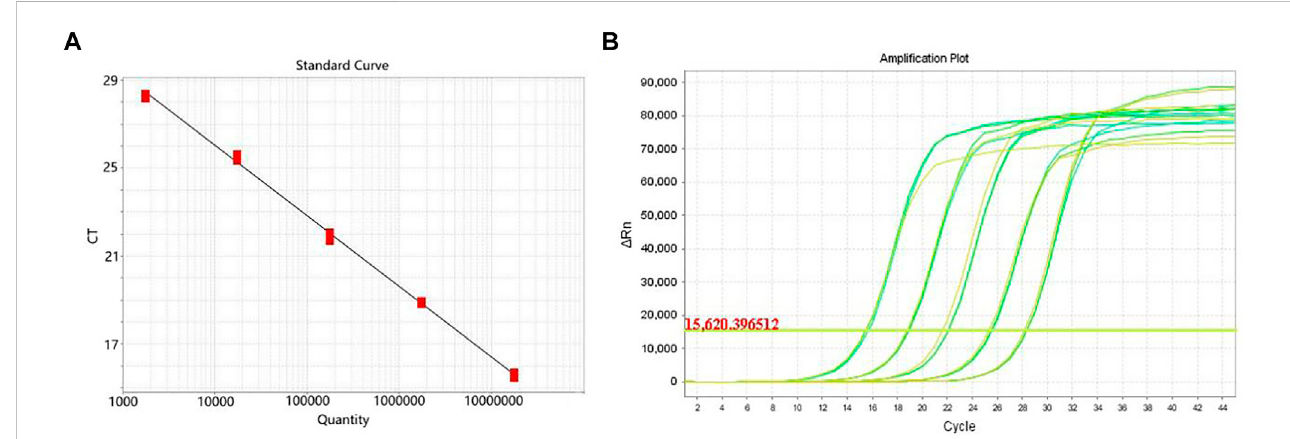
FIGURE 9 Detection sensitivity of RTFQ-PCR using standard strain of Klebsiella pneumoniae . (A) The standard curve of the RTFQ-PCR for the detection of 5 Klebsiella pneumoniae DNA samples from 5.8 × 10 − 2 to 5.8 × 10 − 6 ng/ μ L; (B) The ampli fi cation curves of RTFQ-PCR method of these 5 Klebsiella pneumoniae samples with different concentrations. Numbers 1 – 5 represent the different concentrations.